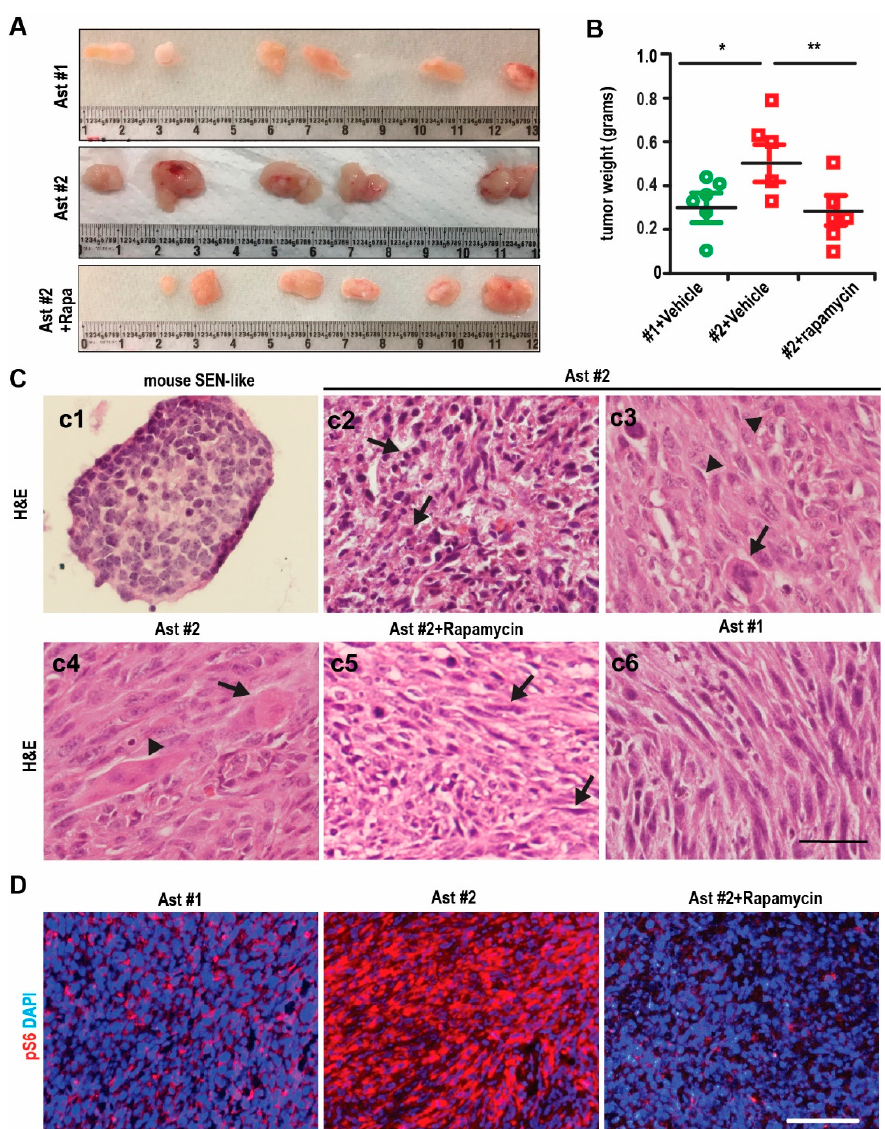
Figure 4. Formation of tumors from immortalized cell lines Ast #2 in vivo. ( A ) Representative images of tumors from immortalized Ast #1 cells treated with vehicle and Ast #2 cells treated with vehicle or Rapamycin for 2 weeks. ( B ) Mean ± S.E. of the tumor weight from Ast #1 cells treated with vehicle and Ast #2 cell treated with vehicle or Rapamycin for 2 weeks were shown. n = 6. ( C ) H&E staining of tumors from immortalized Ast #2 cells treated with vehicle or Rapamycin and Ast #1 cells treated with vehicle. ( D ) Immunofluorescent staining of pS6 and DAPI in Ast #1 tumors treated with vehicle or Ast #2 tumors treated with vehicle or Rapamycin. Two-way ANOVA and Tukey post hoc tests were used for statistic tests. * p < 0.05, ** p < 0.01. Bar = 50 µ